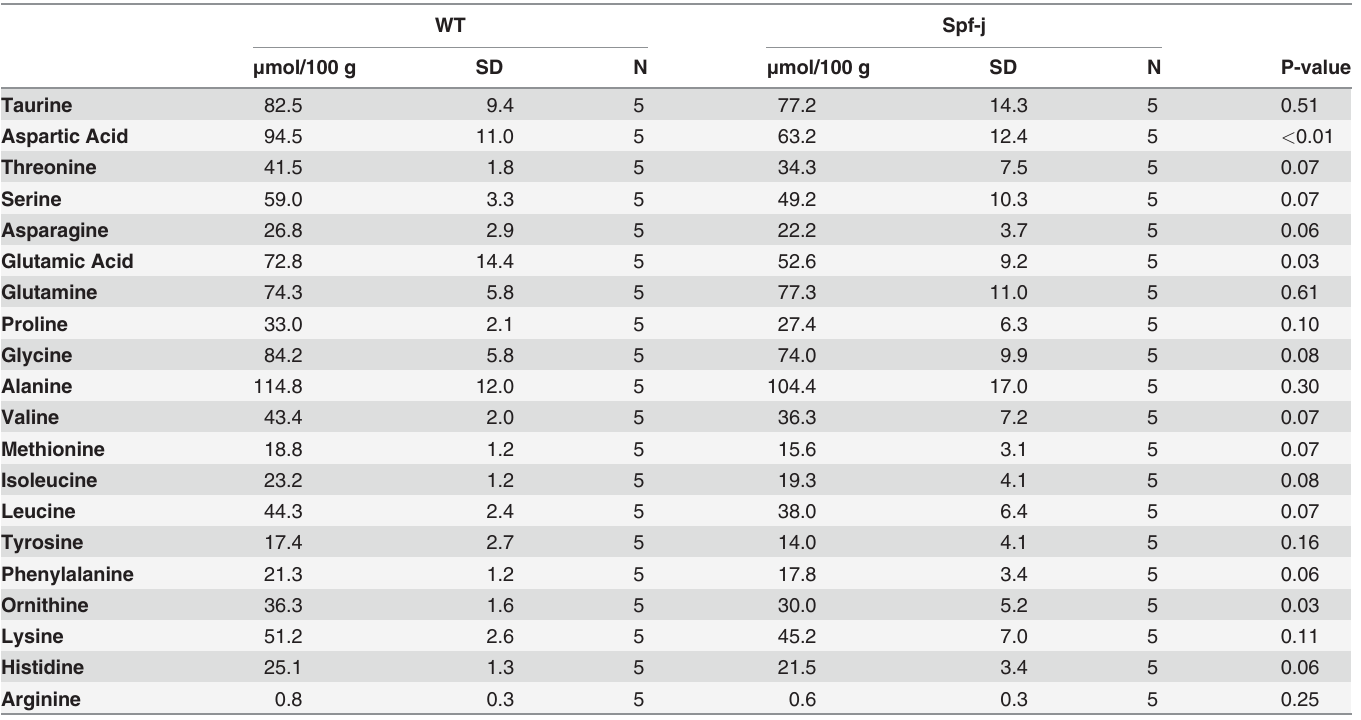
Table 2. Liver amino acid concentrations at